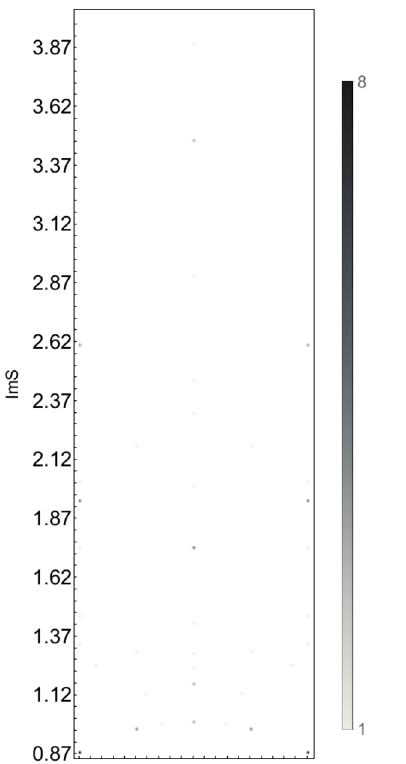
Figure 2 . The numbers of the stable vacua on (Re S; Im S ) plane for N max and N max = 1000 in the right panel, (cid:13)ux